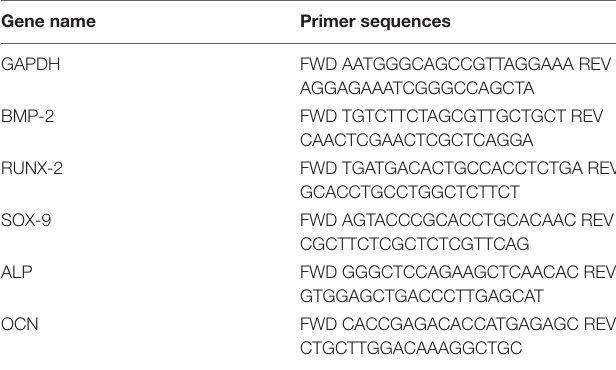
TABLE 2 | List of primer sequences used for reverse transcription and real-time